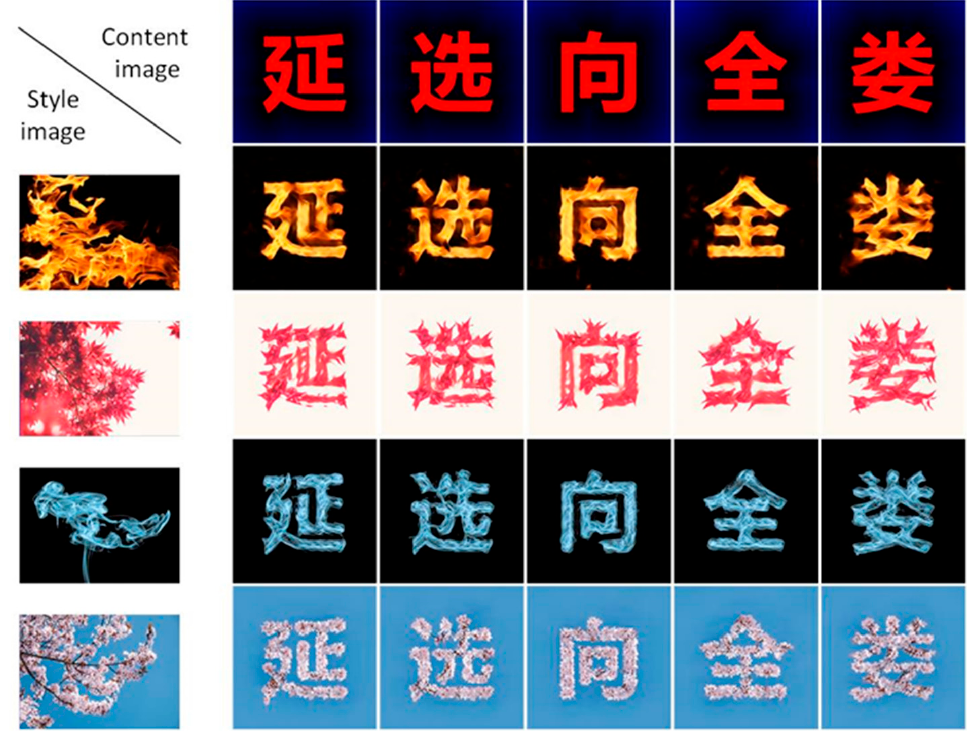
Figure 4. Our artistic text style transfer effects.